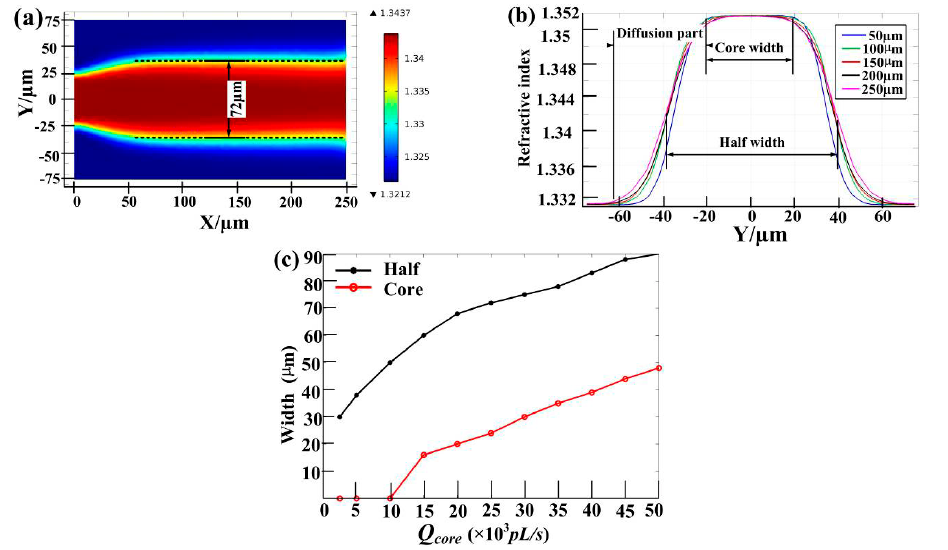
Figure6. ( a ) The refractive index profile in the xoy plane with Q core = 25 × 10 3 pL/s; ( b ) The cross-sectional refractive index profiles at five different locations ( x = 50, 100, 150, 200 and 250 μm) at Q core = 25 × 10 3 pL/s; ( c ) The variation of core width and half width with different Q core .